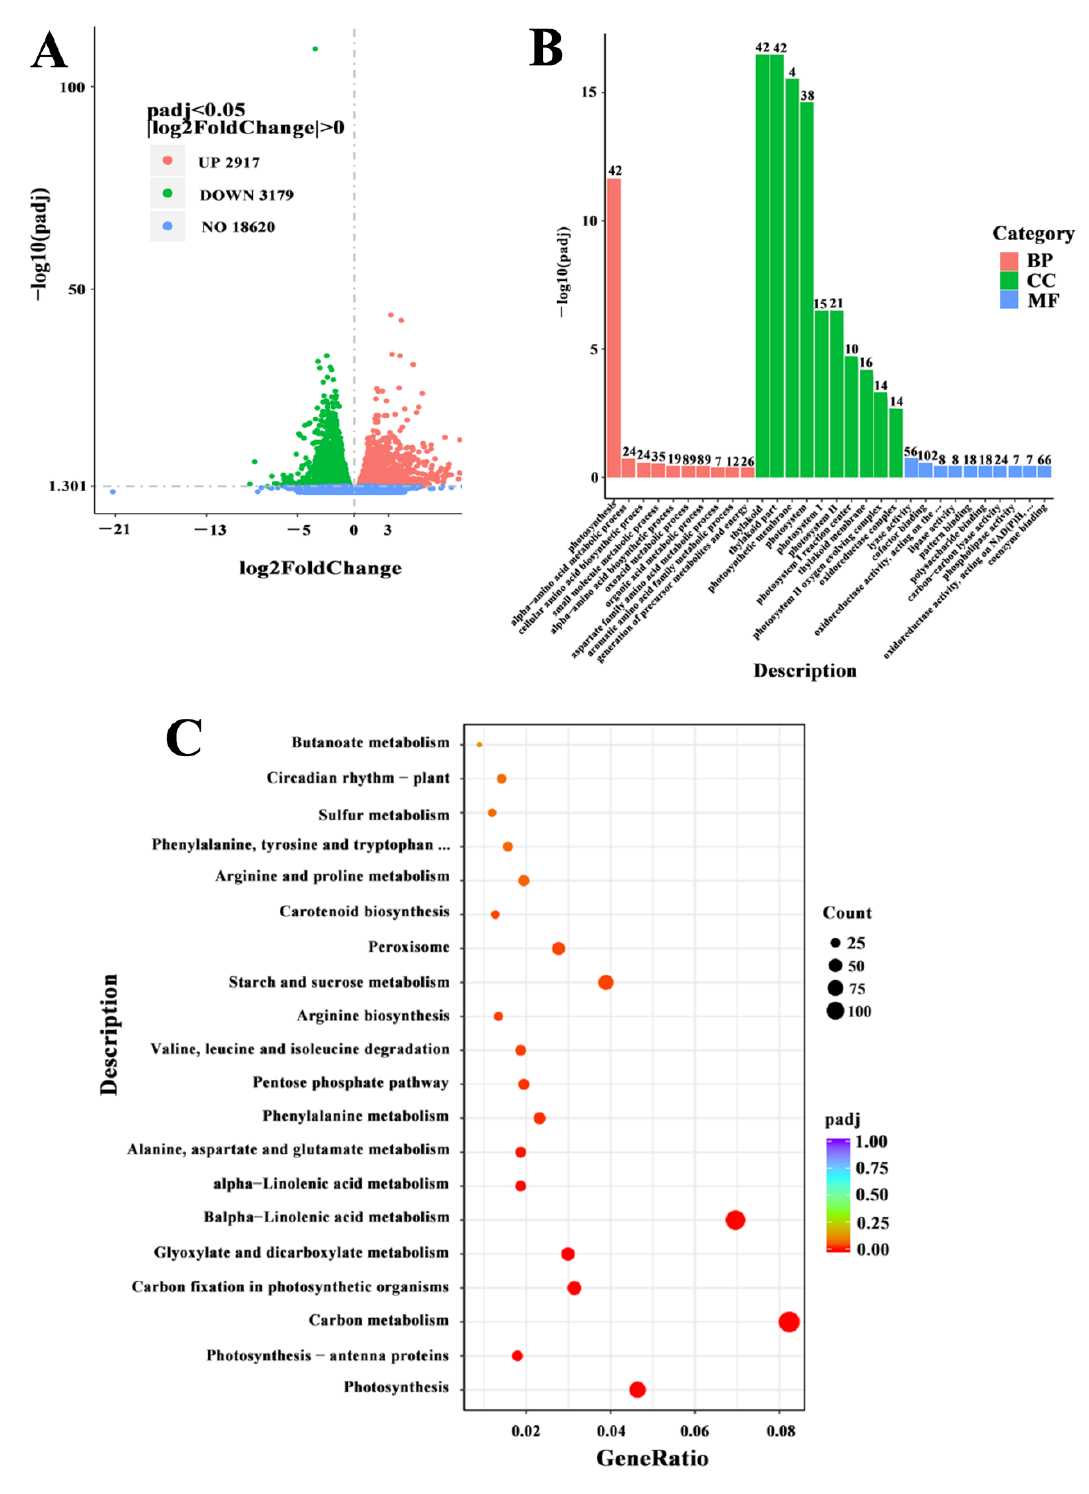
Figure 2. Transcriptome profiling analysis during salt stress. ( A ) The volcano plot showed the numbers of significantly differentially expressed genes (DEGs). Red points represent upregulated genes, green points represent downregulated genes, and blue points represent no differences. ( B ) Functional gene ontology (GO) term classifications of DEGs. GO terms were summarized in three main categories of cellular component, molecular function, and biological process. ( C ) The DEGs enrichment in different KEGG pathways. vs.: Versus.